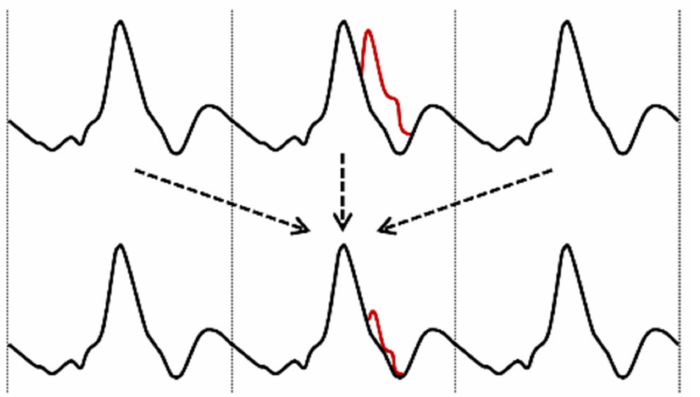
Figure 4. Principle of EA algorithm—black is the bioimpedance signal dZ/dt, red is the artifact in the current heartbeat cycle. Heartbeats around the current beat are aligned, scaled, and merged. The arrows indicate the used heartscycles for the